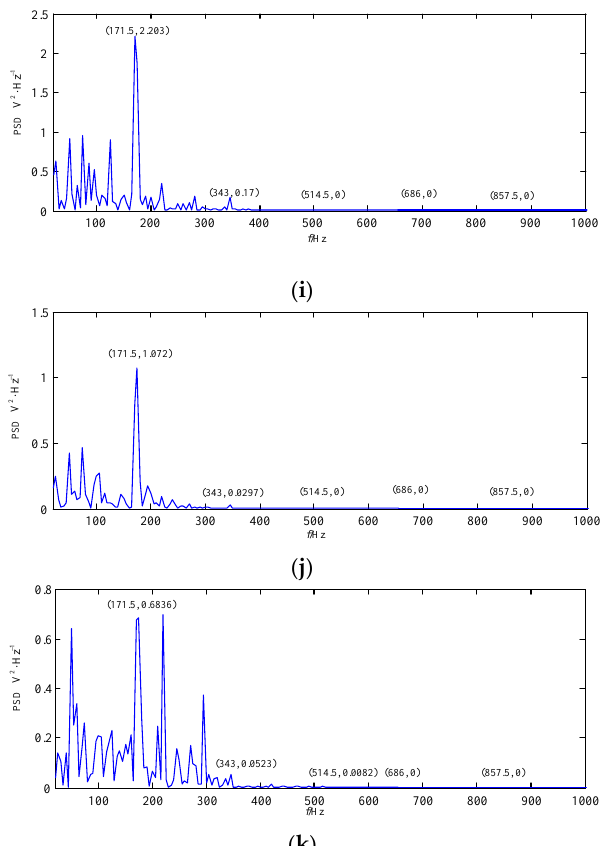
Figure 18. The best decomposition results of the loose slipper fault signal based on IEWT in the frequency domain. ( a ) F 11 ; ( b ) F 10 ; ( c ) F 9 ; ( d ) F 8 ; ( e ) F 7 ; ( f ) F 6 ; ( g ) F 5 ; ( h ) F 4 ; ( i ) F 3 ; ( j ) F 2 ; ( k ) F 1 .